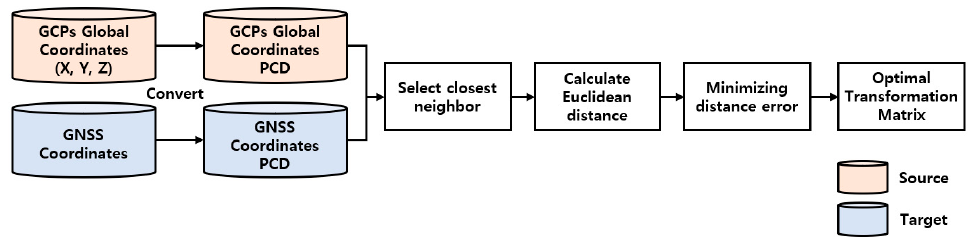
Figure 4. Performance sequence of transformation matrix estimation process.